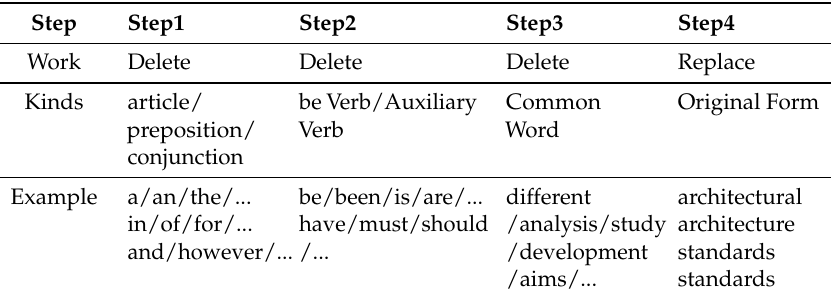
Table 2. Contents of word dictionary